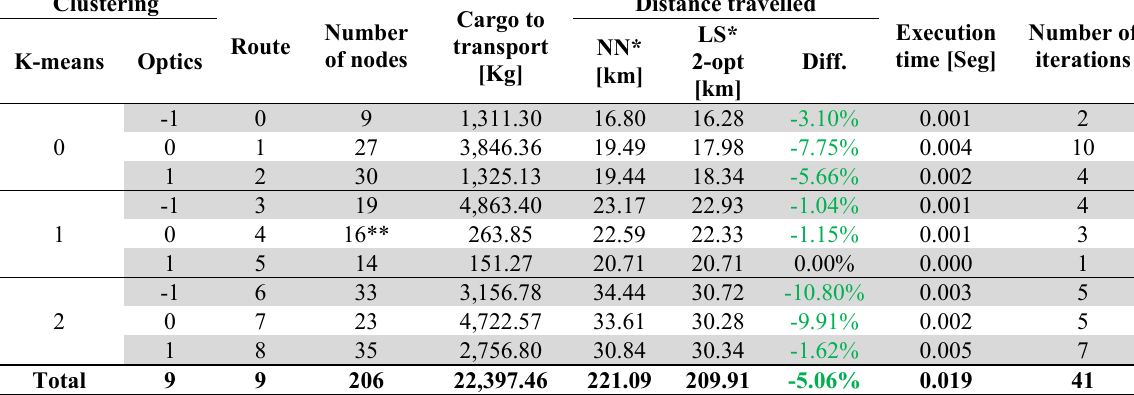
Results per route for 205 nodes (customers)